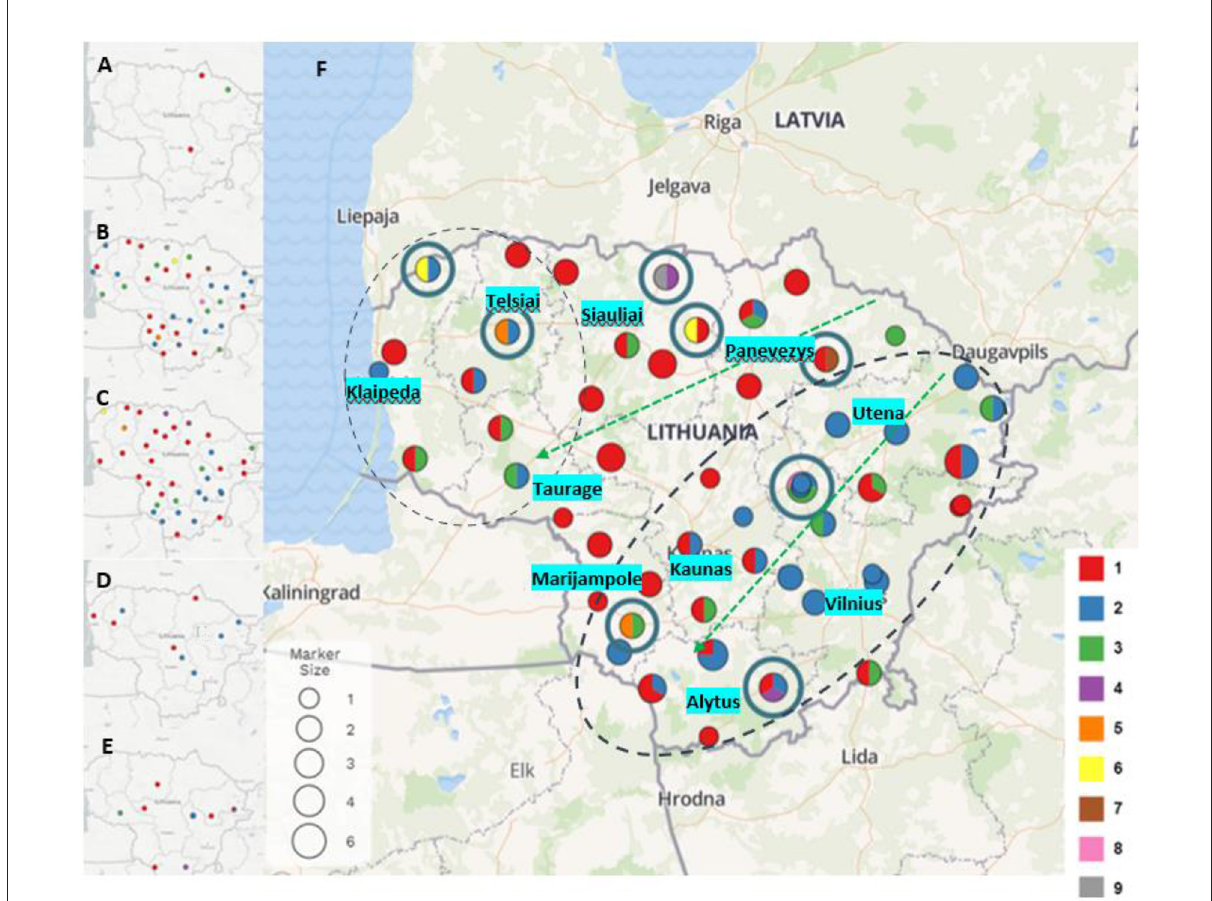
FIGURE2 Paenibacillus larvae MLVA types detected in 2011 (A) , 2015 (B) , 2016 (C) , 2017 (D), and 2021 (E) (type 1- red, type 2 - blue, type 3 - green, type 4 - purple, type 5 - orange, type 6 - yellow, type 7 - brown, type 8 - pink, type 9 - gray). Map (F) visualizes all P. larvae samples and all MLVA types collected and investigated over the years. Dot size indicates the number of samples collected in the same or nearby apiaries over the years (from 1 to 6). Dots with blue circles indicate the rarest MLVA types (types 4, 5, 6, 7, 8, and 9). Green arrows show distribution of MLVA type 3, and two black dash circles show distribution of MLVA type 2 over the